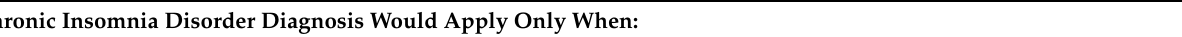
Table 1. Diagnostic criteria for comorbid Insomnia